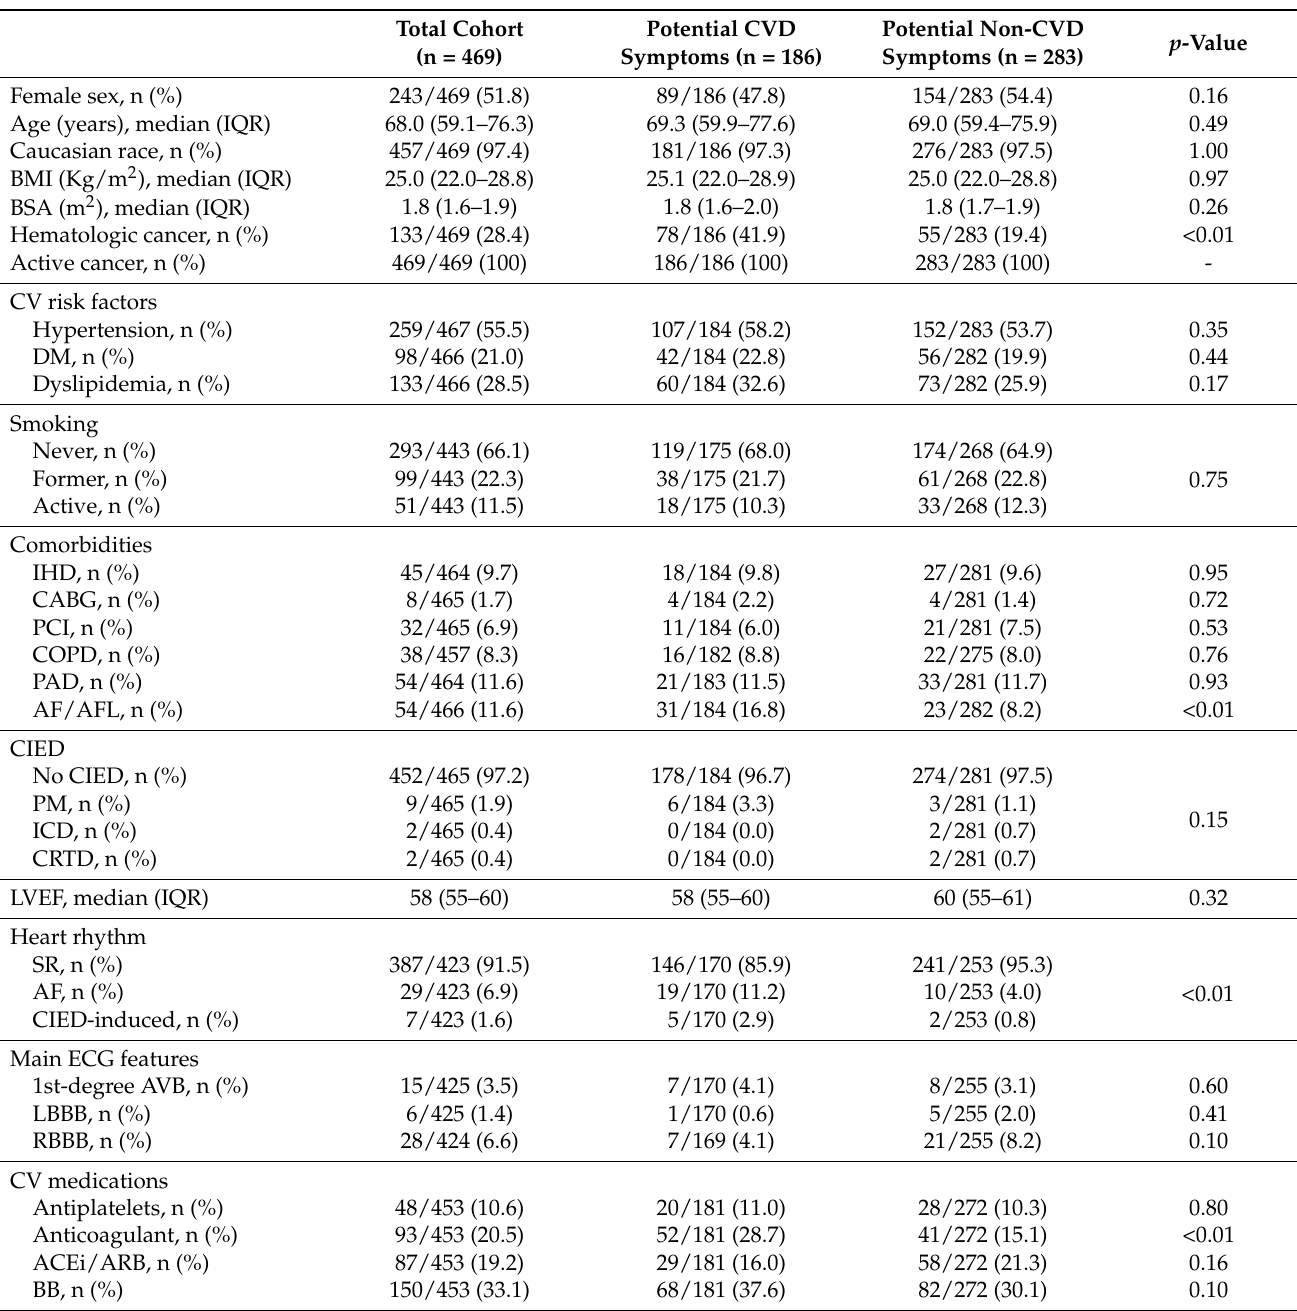
Table 1. Baseline characteristics of study population according to symptoms at